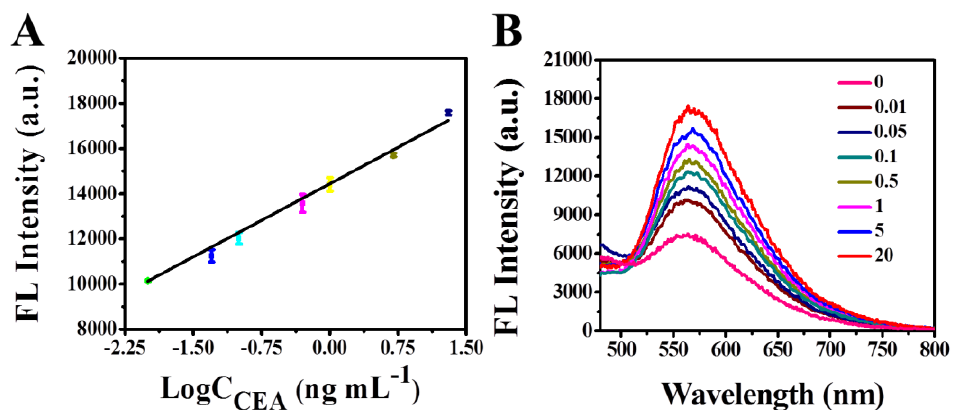
Figure 5. ( A ) The linear calibration plot for CEA determination (0.01 – 20 ng mL −1 , log C vs. fluores- cence intensity at 565 nm) (error bars: SD, n = 3), ( B ) fluorescent determination of CEA based on CP/ZIF-8/PDA nanoparticles by self-supplied H 2 O 2 (the concentration of CEA: 0, 0.01, 0.05, 0.1, 0.5, 1, 5, 10 and 20 ng mL −1 ).